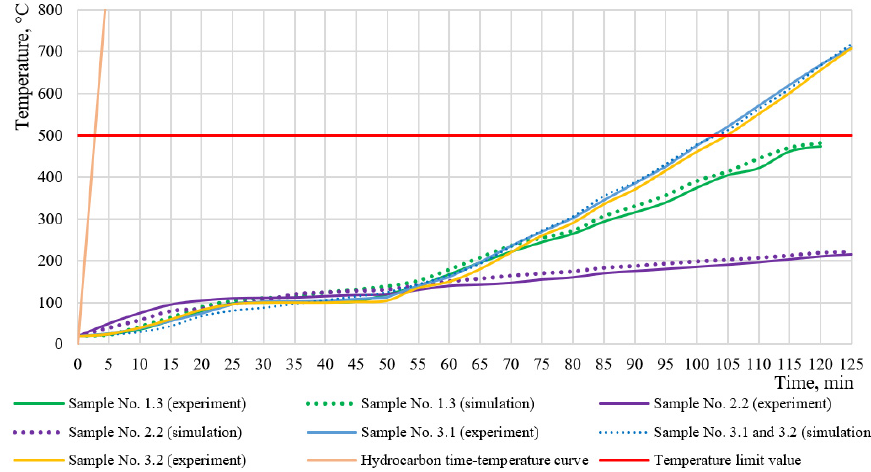
Figure 10. Experimental and calculated temperature curves of samples during fire exposure under hydrocarbon fire regime.